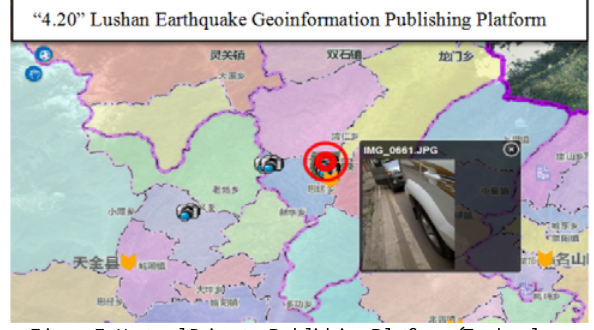
Figure 7. Natural Disaster Publishing Platform (Technology Innovation Center of Emergency Surveying and Mapping, 2013)